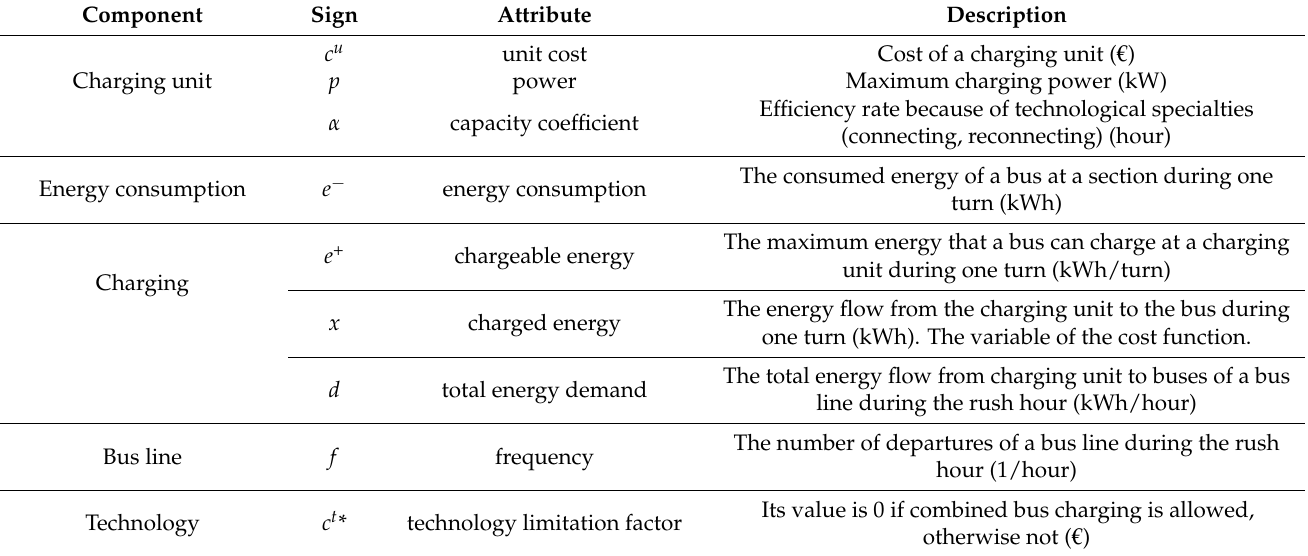
Table 2. Attributes of public electric bus service.